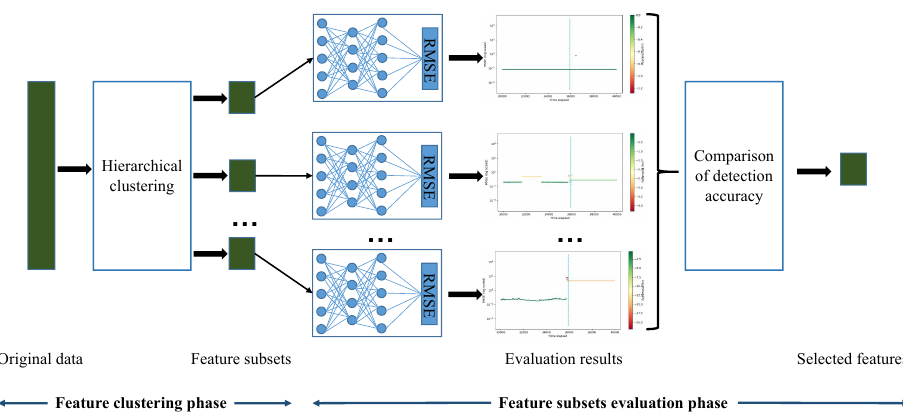
Figure 3. The architecture of feature selection